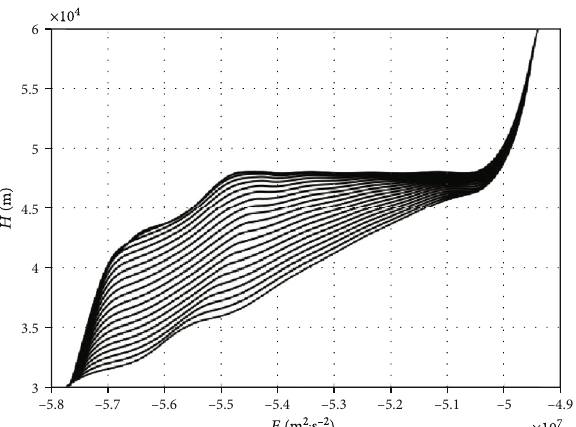
Figure 20: Bank angle pro fi les for Case 1.